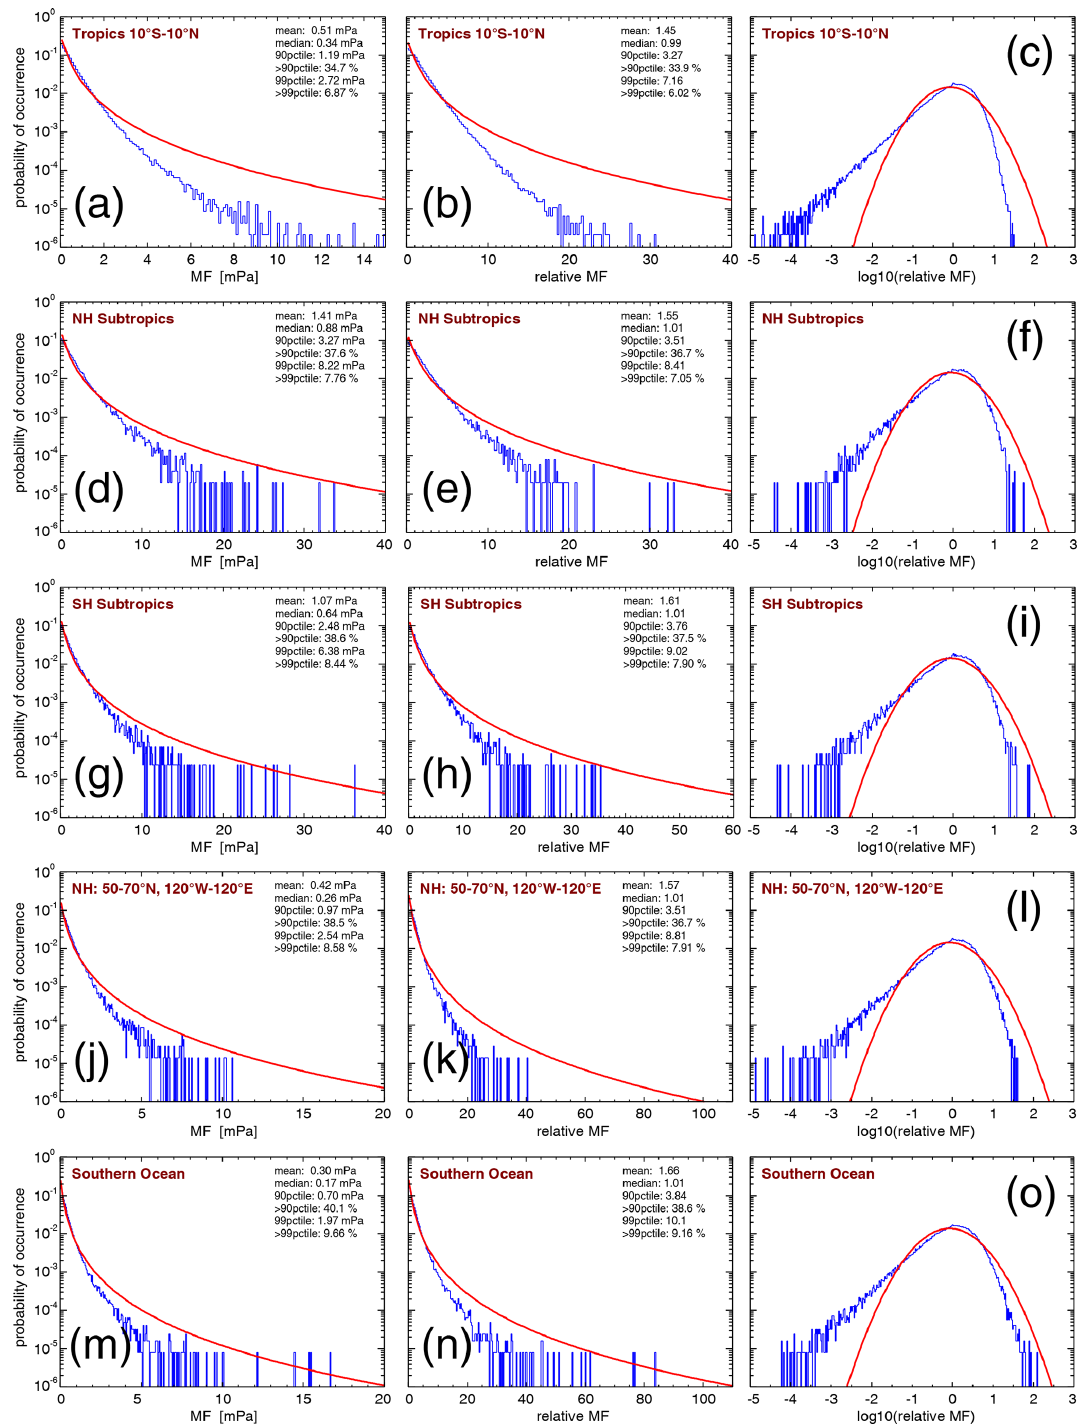
Figure 7. PDFs of HIRDLS gravity wave absolute momentum fluxes (MF) at 30km altitude in the tropics for the period from January 2005 until February 2008 ( a – c ), for the three hot spots of gravity wave activity in the subtropics of the Northern Hemisphere during boreal summer (JJA) ( d – f ), for the three hot spots of gravity wave activity in the subtropics of the Southern Hemisphere during austral summer (DJF) ( g – i ), for the Northern Hemisphere midlatitude–high-latitude region from 50 to 70 ◦ N and from 120 ◦ W to 120 ◦ E during boreal summer (JJA) ( j – l ), and for the Southern Ocean region from 50 ◦ S to 65 ◦ N without the longitudes from 80 to 30 ◦ W during austral summer (DJF) ( m – o ). For an illustration of the locations of the different regions, see Fig. 5. Panels (a) , (d) , (g) , (j) , and (m) show gravity wave absolute momentum flux in millipascals (mPa), whereas the remaining panels show relative momentum